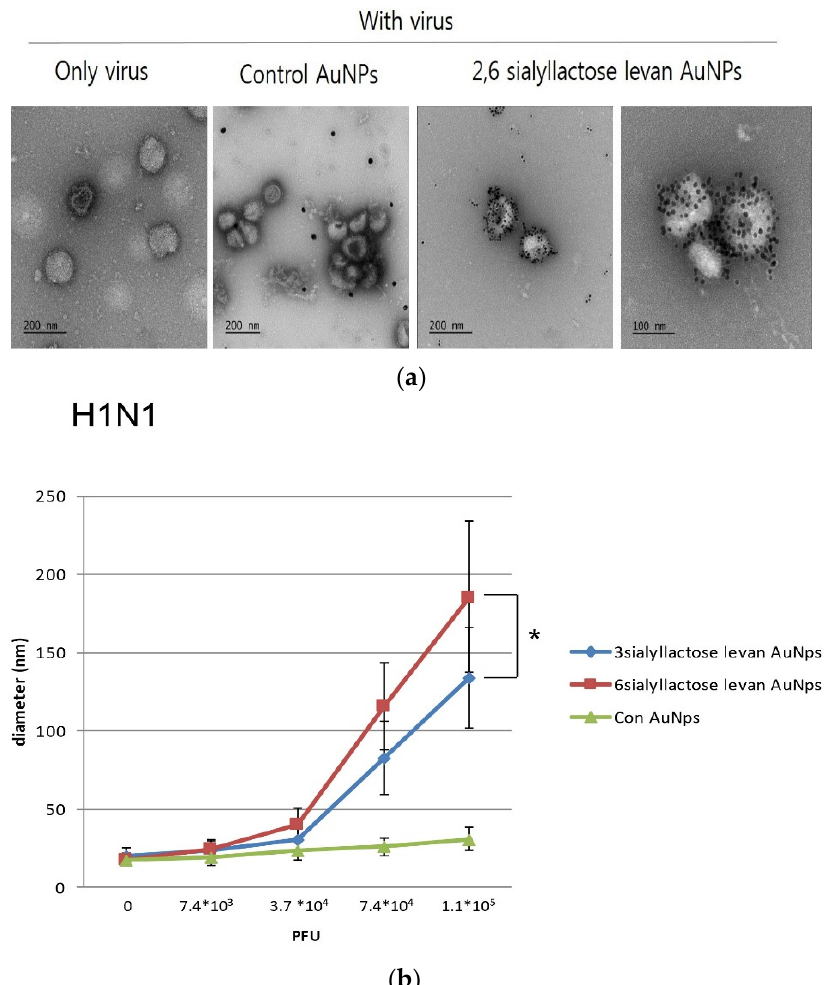
Figure 4. TEM images of virus-AuNP mixtures ( a ). The hydrodynamic diameter of nanoparticles through the reaction between each prepared nanoparticles and each concentration of influenza virus H1N1 as measured using DLS ( b ) (* p < 0.05).